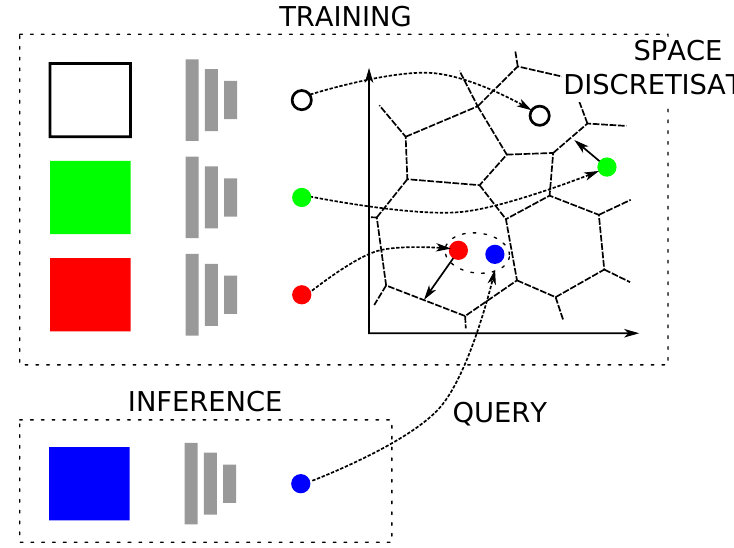
Figure 2. The Frequency-Modulated Continuous Wave (FMCW) radar place recognition (RPR) pipeline, from Reference [8]. The offline stages of the pipeline involve enforcing and discretising the metric space, while the online stages involve inference to represent the place the robot currently finds itself within in terms of the learned knowledge and querying the discretised space, in this case depicted using a Voronoi-like structure, which encodes the trajectory of the